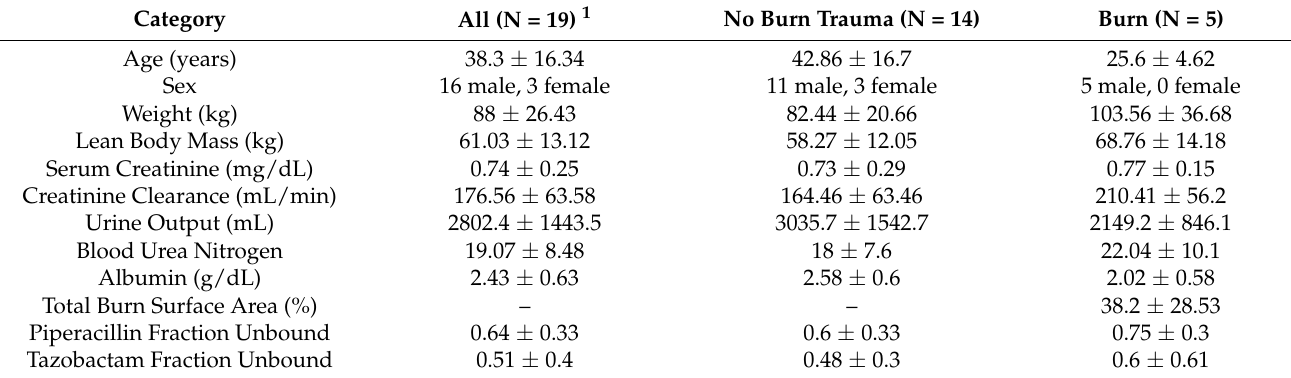
Table 1. Demographics of the total, burn and no-burn